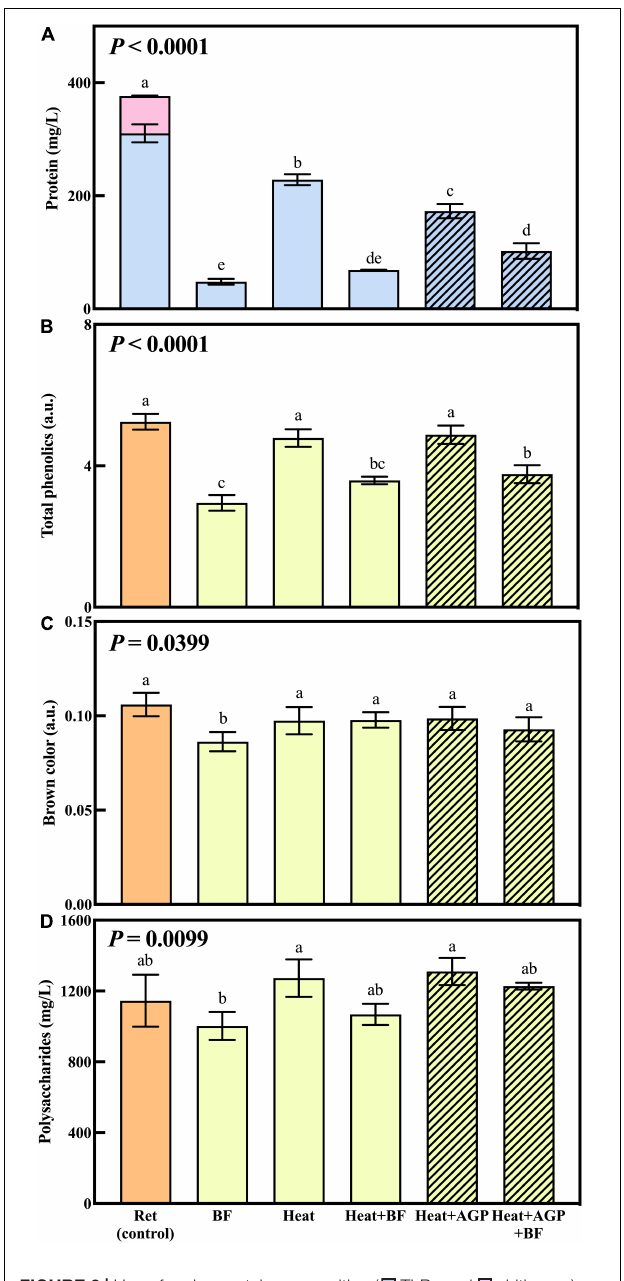
FIGURE 2 | Haze-forming protein composition ( TLPs and chitinases) (A) , total phenolics (B) , brown color (C) , and polysaccharide concentrations (D) of untreated retentate (control) and retentate treated via bentonite fining (BF) and/or heating (10 min at 62 ◦ C), with or without AGP (0.05% v/v DSM) addition. Shading denotes retentate treated with AGP. Data are means of three replicates ( ± standard error), with the exception of polysaccharide concentrations of untreated retentate, for which values are means of two replicates. Different letters indicate statistically significant differences (one-way ANOVA, Tukey’s HSD, P <